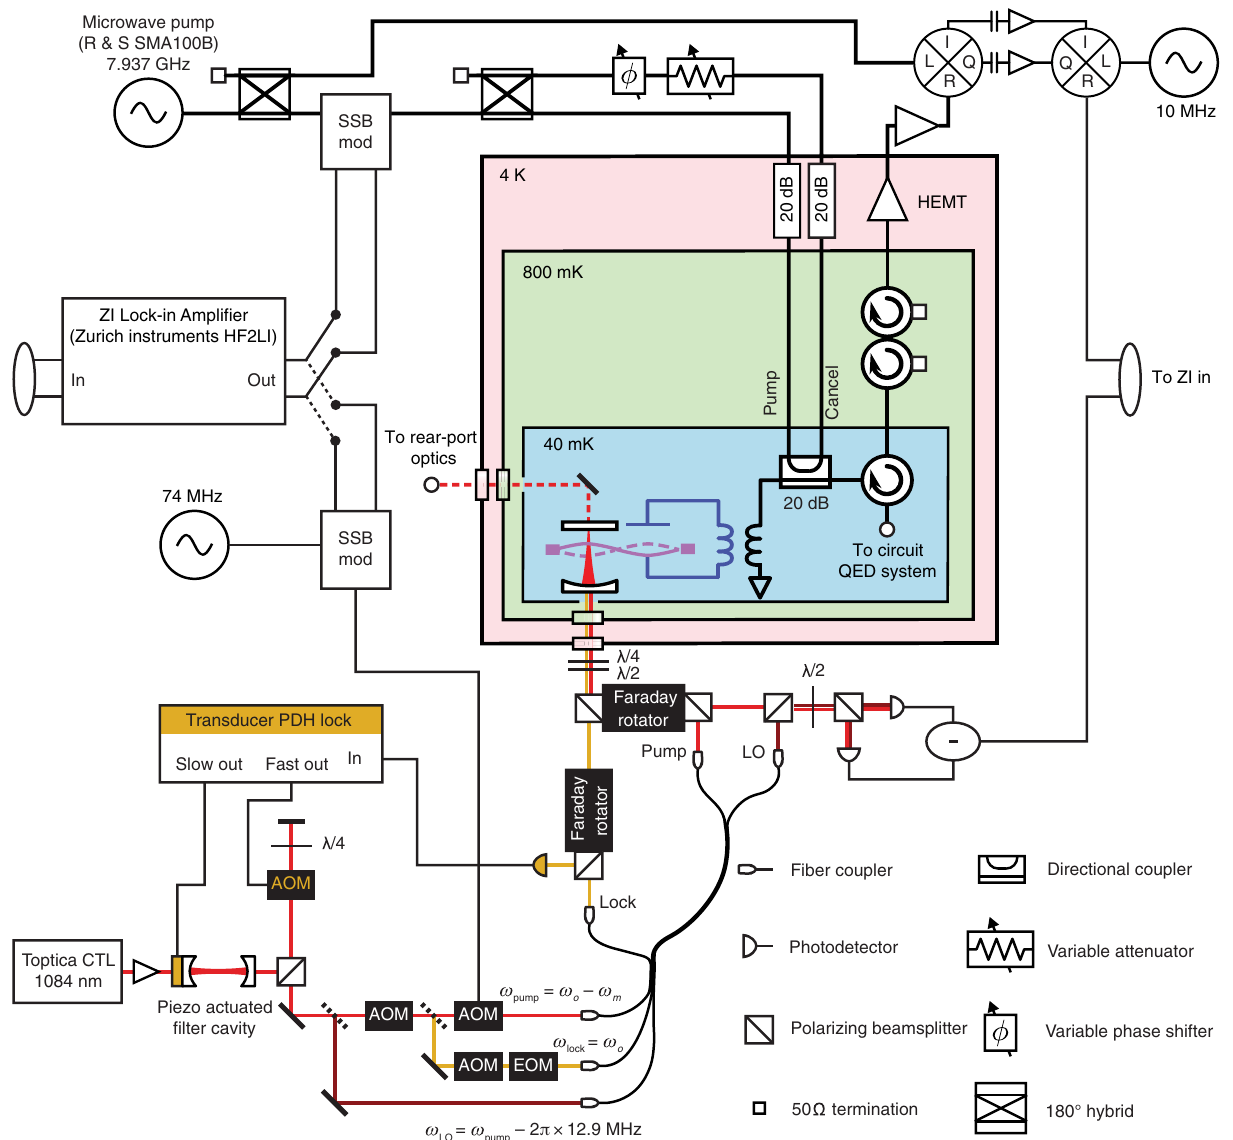
FIG. 5. Experimental setup. Diagram illustrating the system used to control and probe the transducer, comprising microwave (top) and optical (bottom) subsystems along with the lock-in amplifier used for data acquisition (left). Elements used to lock the optomechanical cavity are shown in